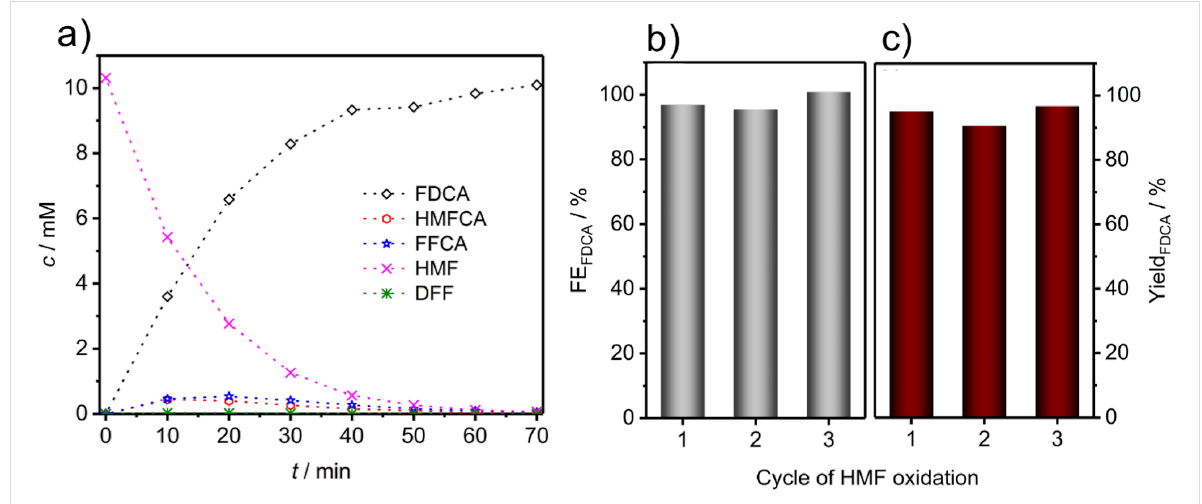
Figure 5: Concentration vs time curve for HMF, HMFCA, DFF, FFCA and FDCA (a); bar diagram of the faradaic efficiency (b) with respect to FDCA formation, and (c) FDCA yield during three consecutive